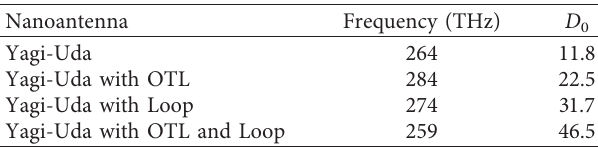
Table 7: Resonance frequency and peak values of directivity of the four nanoantennas.